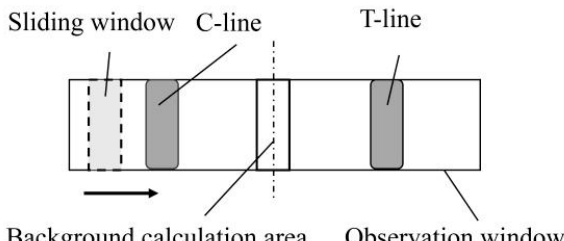
Figure 2. Schematic of sliding window detection.